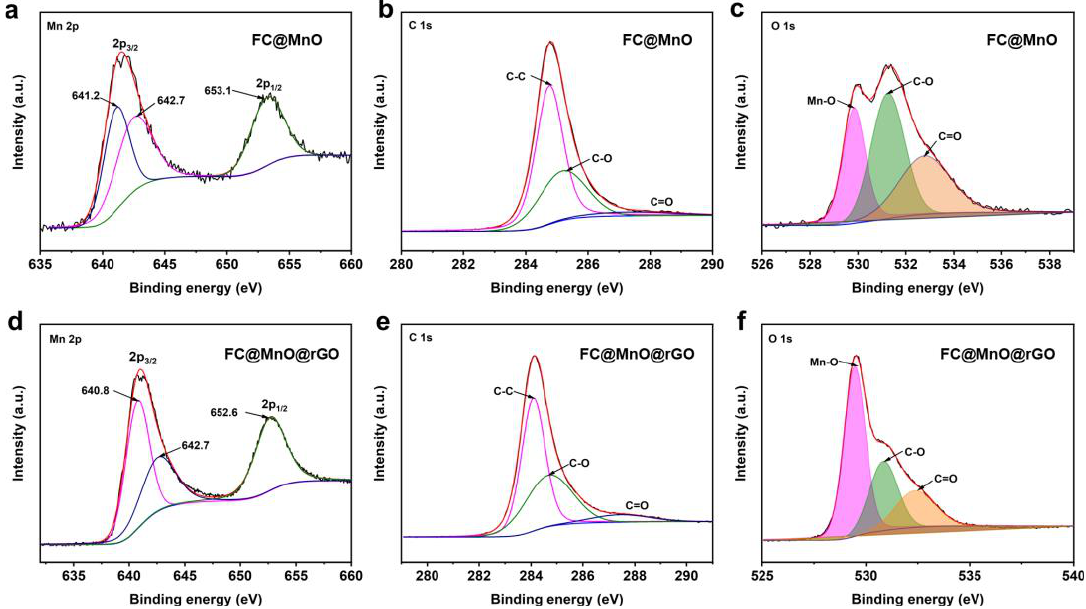
Figure 3. High-resolution spectra of the ( a – c ) Mn 2p, C 1s and O 1s peaks of FC@MnO, ( d – f ) Mn 2p, C 1s and O 1s peaks of FC@MnO@rGO, respectively.